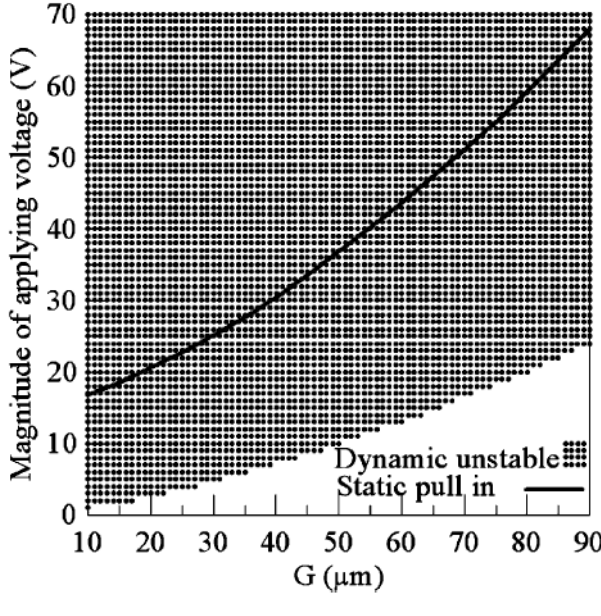
Figure 7. Comparison between dynamic instability and static pull-in